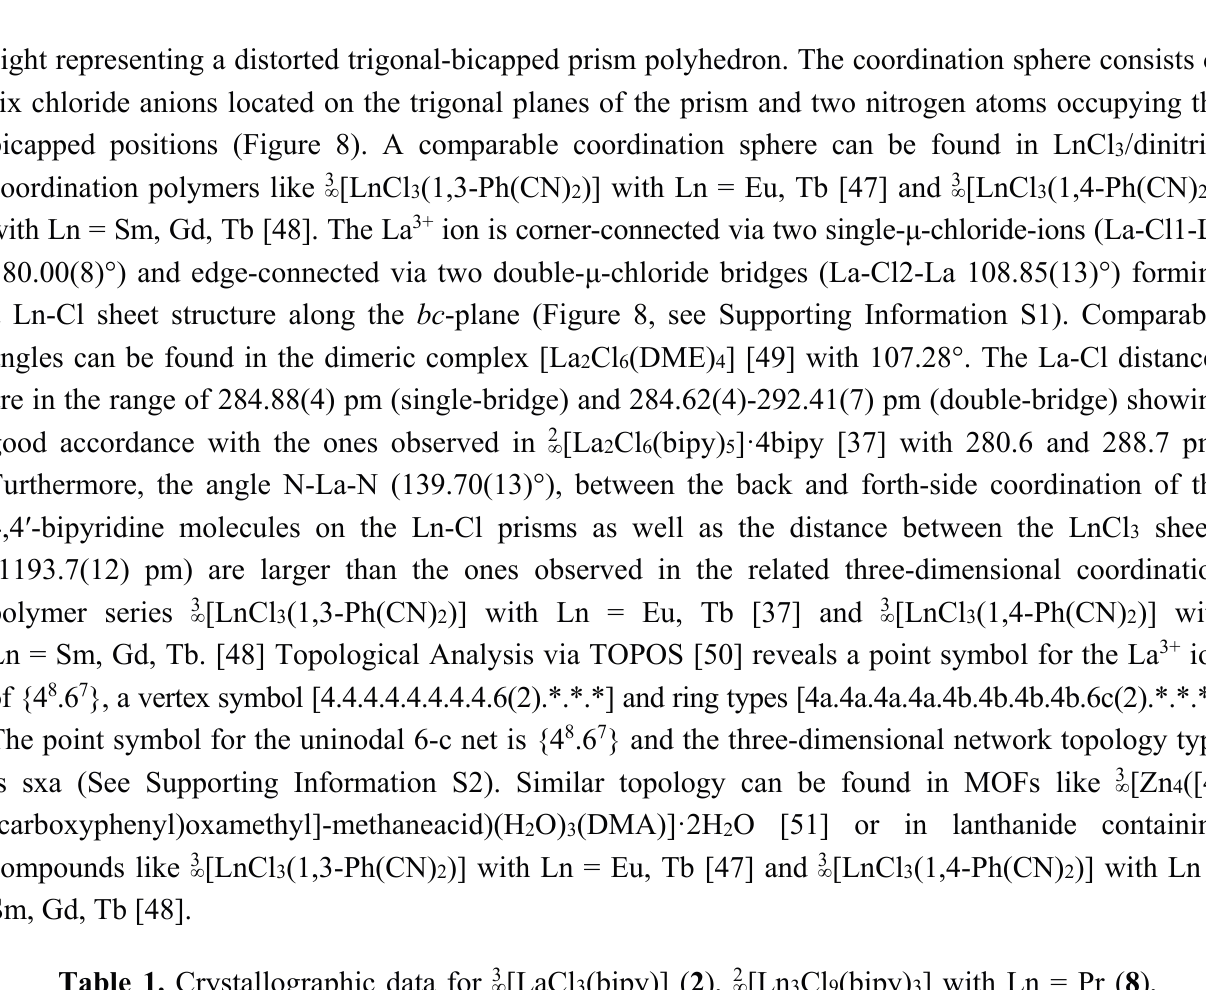
Table 1. Crystallographic data for 3 ∞ [LaCl 3 (bipy)] ( 2 ), 2 ∞ [Ln 3 Cl 9 (bipy) 3 ] with Ln = Pr ( 8